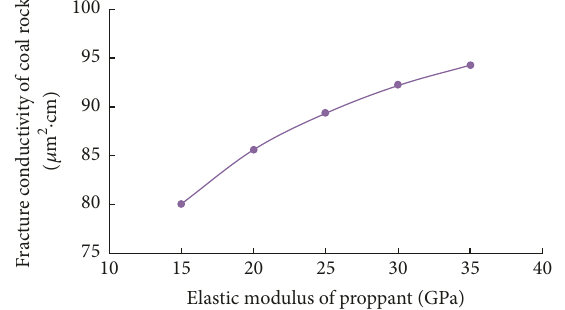
Figure 11: Relationship curve of fracture conductivity and elastic modulus of coal rock.